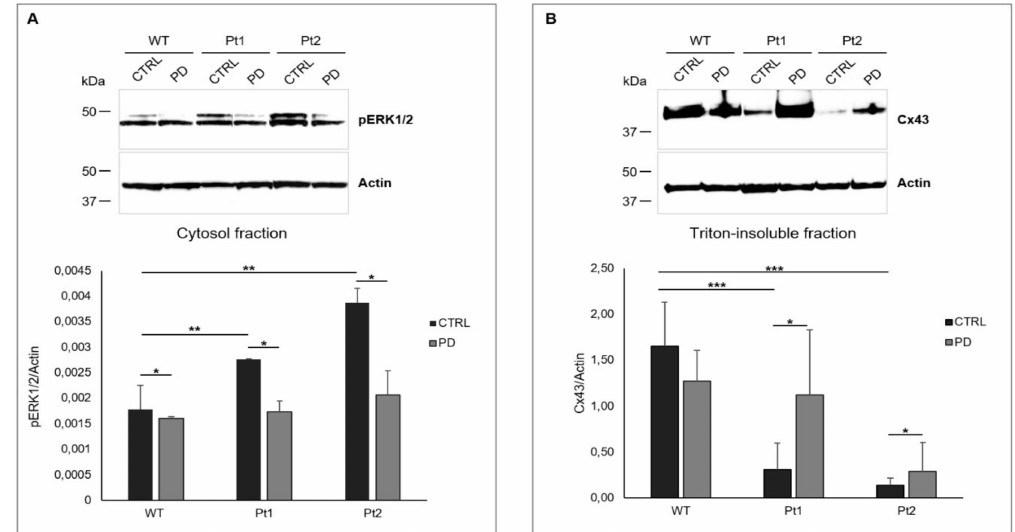
Figure 7. pERK1 / 2 inhibition rescues Cx43 partitioning in gap-junction fractions in U251 cells expressing MLC1 mutants. ( A ) WB analysis performed with 40 µ g of cytoplasmic protein extract of MLC1 expressing cell lines, untreated (CTRL) or treated with 50 µ M of the pERK1 / 2 inhibitor PD98059 (PD) for 1 h, confirms the inhibition of pERK1 / 2 activation in all the U251 cell lines analyzed. Actin is used as a loading control. Molecular weight markers are indicated on the left (kDa). One representative experiment out of three performed is shown. Densitometric analysis of pERK1 / 2 protein bands normalized with the amount of actin is evaluated for each cell fraction. The bar graphs represent means ± SEM of three independent experiments. Significant di ff erences are calculated using the Kruskal-Wallis test followed by Dunn’s Multiple Comparison post hoc test. (* p < 0.05 and ** p < 0.01). ( B ) WB analysis of Triton-insoluble, gap-junction fractions (60 µ g of protein extract) of MLC1-expressing cell lines, untreated (CTRL) or treated (PD) for 1 h with PD98059 (50 µ M), reveals increased Cx43 levels in Pt1- and Pt2-treated cells when compared to their untreated controls (CTRL). No strong alterations of Cx43 distribution occurs in PD-treated WT MLC1 cells when compared to the corresponding untreated cells (CTRL). Actin is used as a loading control. Molecular weight markers are indicated on the left (kDa). One representative experiment out of five performed is shown. Densitometric analysis of the Cx43 protein band normalized with the amount of actin in the same samples is evaluated for each cell fraction. The bar graphs represent means ± SEM of five experiments. Statistical di ff erence was calculated using the Kruskal–Wallis test followed by Dunn’s Multiple Comparison post hoc test. (* p < 0.05 and *** p <